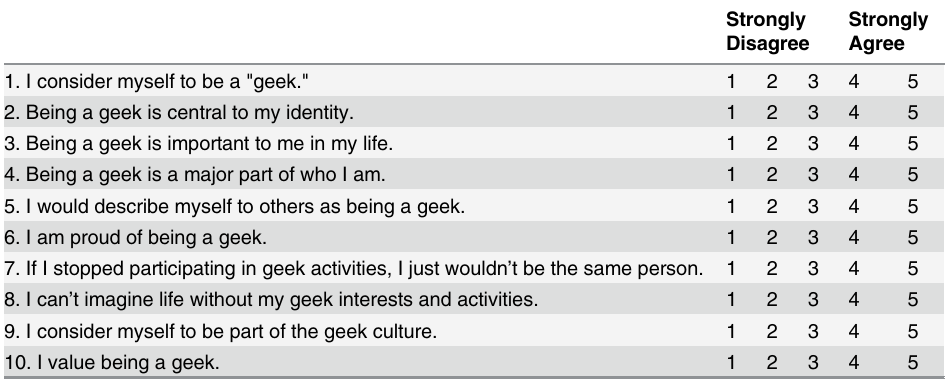
Table 10. Geek Identity Scale (GIS) On a scale from 1 (Strongly Disagree) to 5 (Strongly Agree), please indi- cate your agreement to the following statements: